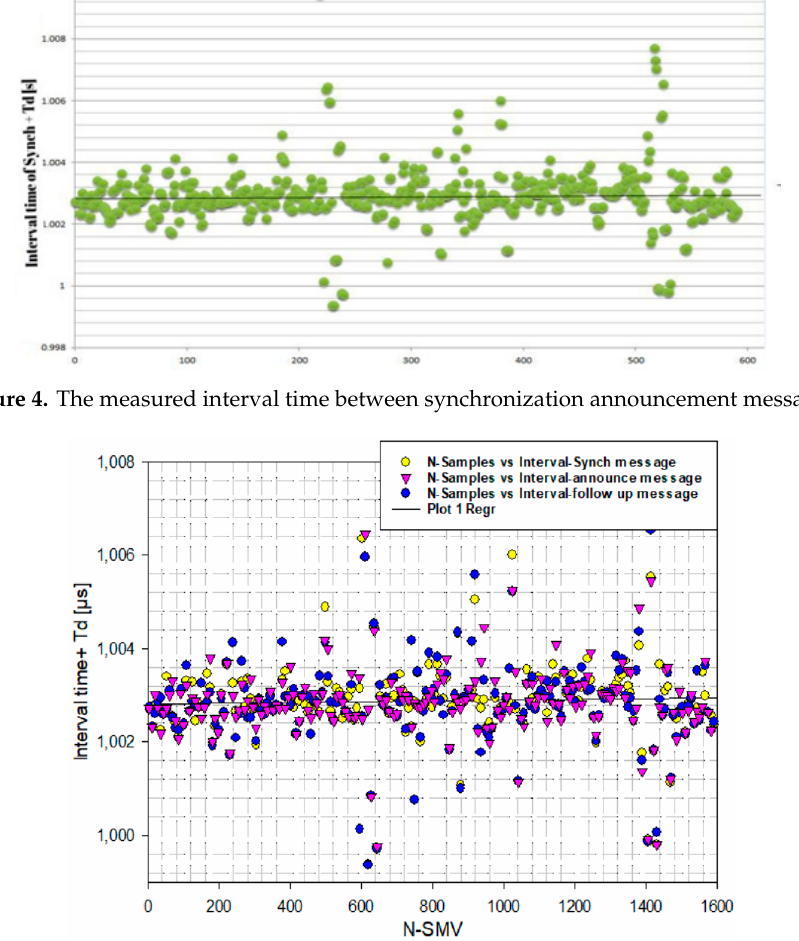
Figure 5. The measured interval time between announcement messages—follow up messages—synch messages of synchronization.